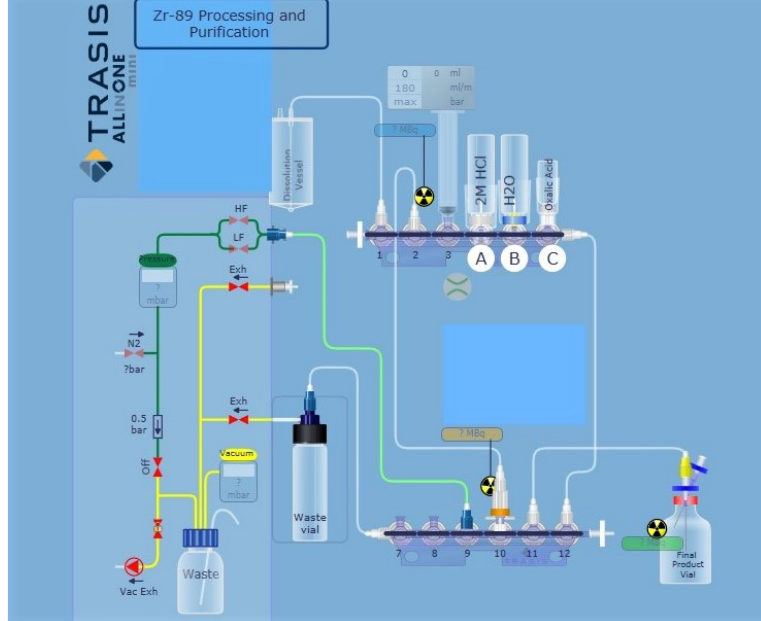
Figure 2. TRASIS miniAiO layout for automated purification and isolation of 89 Zr from irradiated yttrium coin. Valve 1 to dissolution vial; valve 3, 10 mL syringe; valve 4 ( A ) 2 M HCl (20 mL); valve 5 ( B ) water (10 mL); valve 6 ( C ) 1 M oxalic acid (1.5 mL); valve 10 hydroxamate resin; valve 11 to product